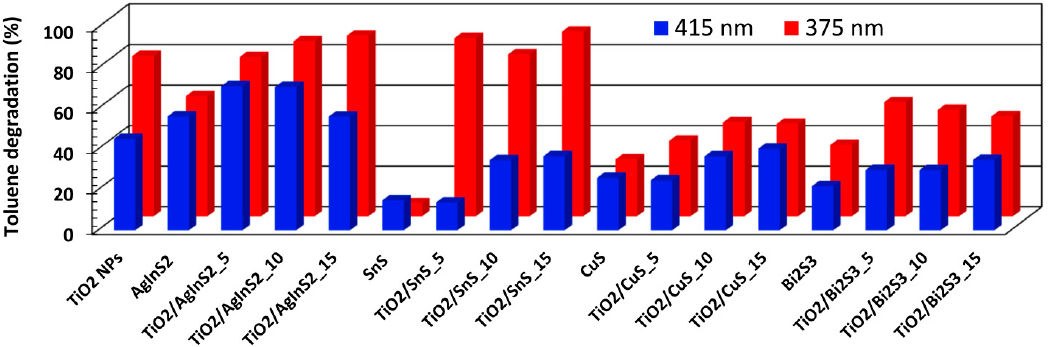
Figure 7. Photocatalytic activities of obtained photocatalysts for toluene photodegradation after 1 h irradiation of LEDs λ max = 375 nm and λ max = 415